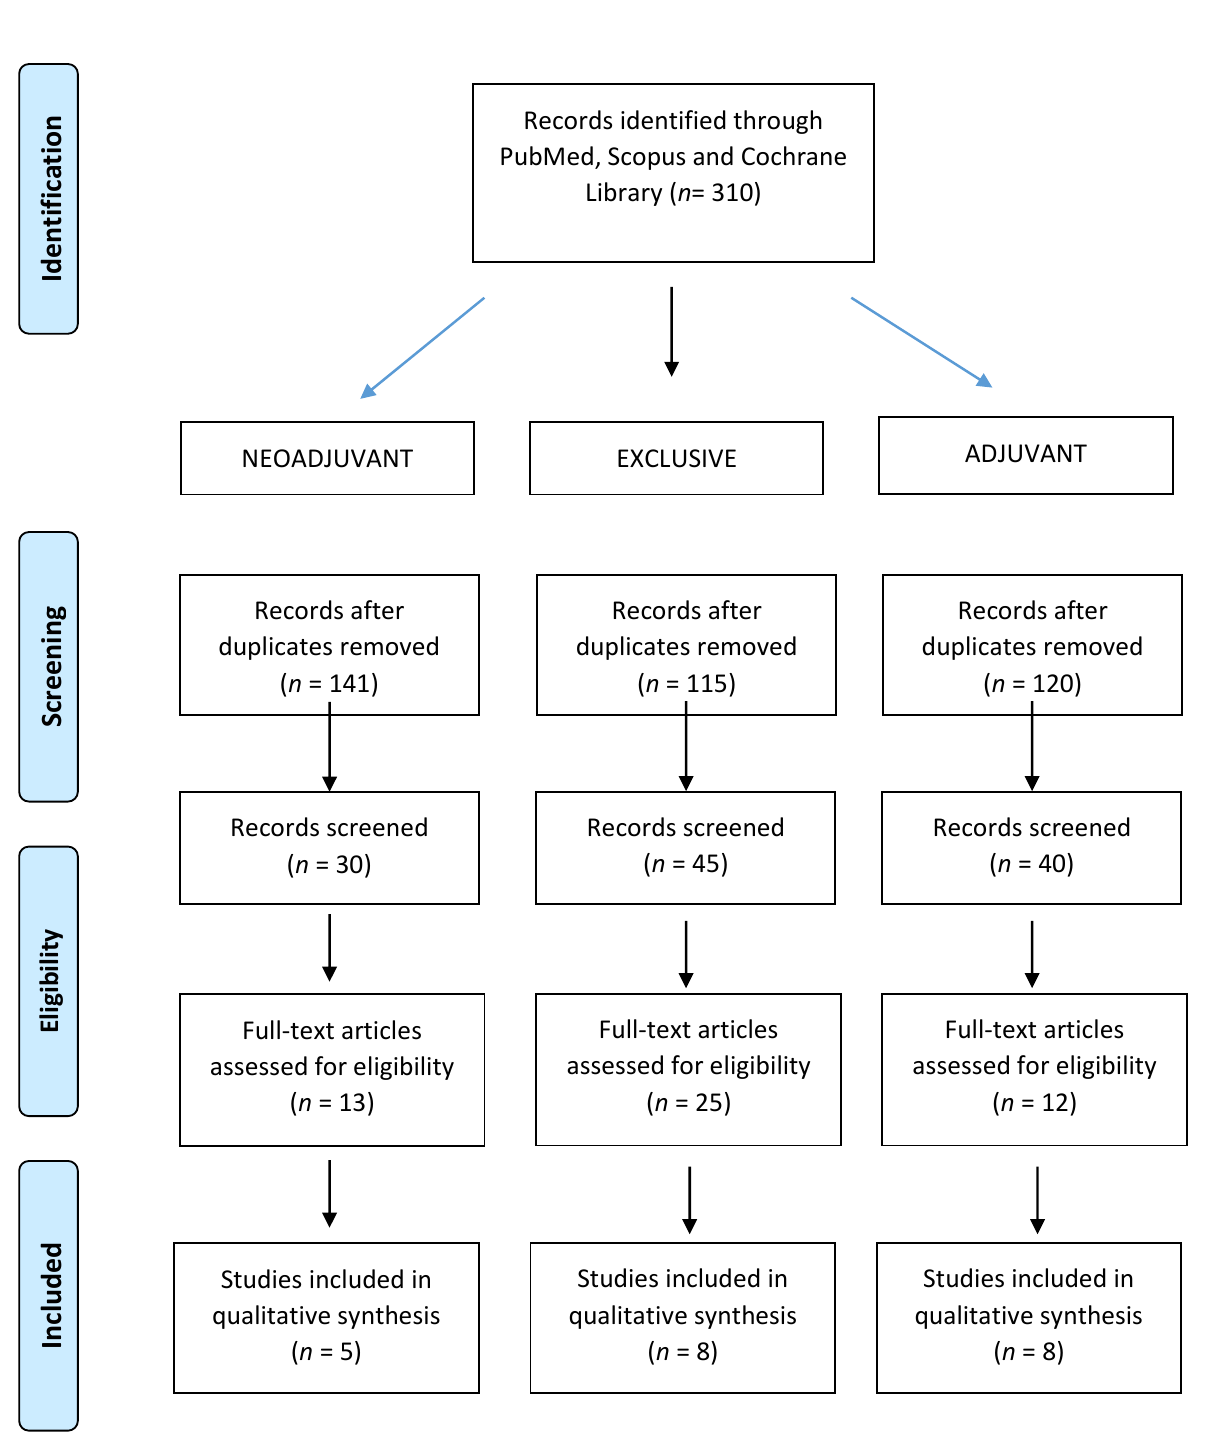
Figure 1. PRISMA Flow-chart for outcomes and toxicity.